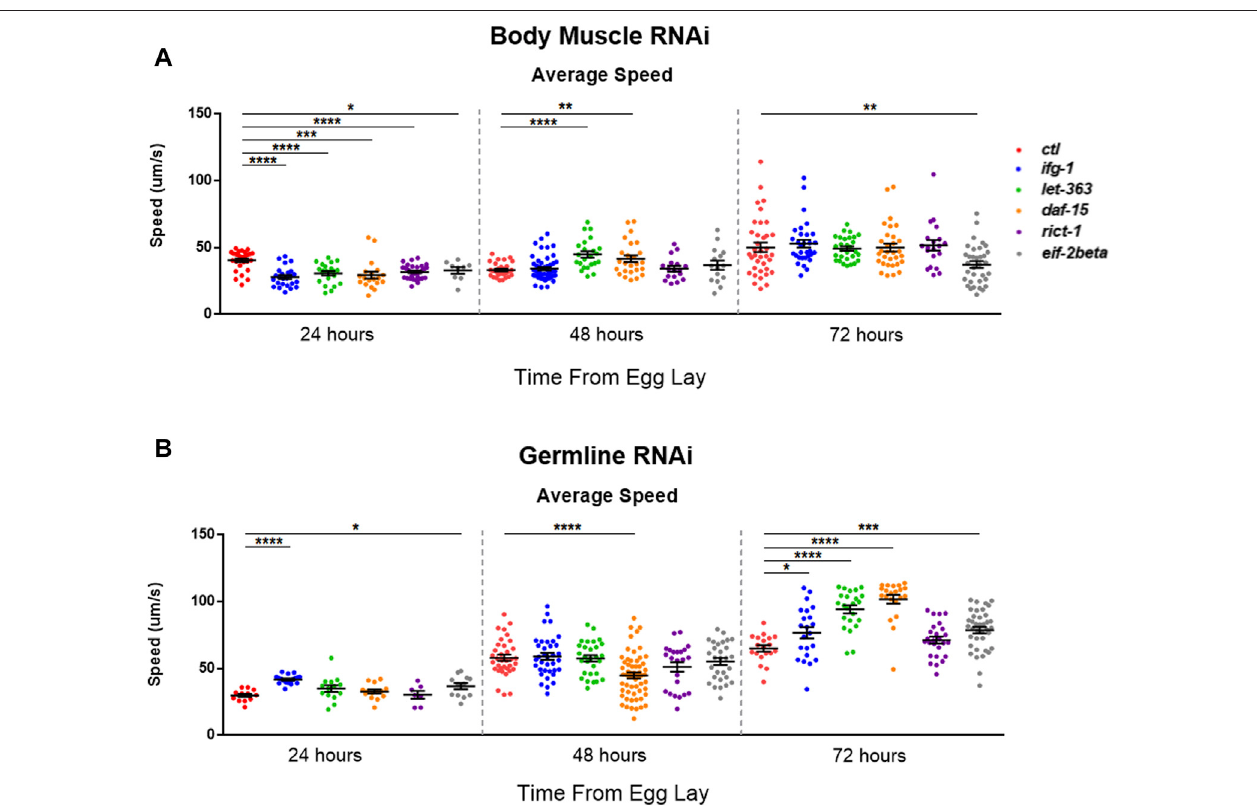
FIGURE 6 | Restricting mTOR in the germline increases motility while restriction in body muscle decreases motility.Average speed was measured on animals fed bacteria expressing dsRNA throughout development for the genes shown. (A) Motility in the WM118 body muscle-speci fi c RNAi strain at 24-, 48-, and 72-h. (B) Same as in (A) , but for motility in theMAH23germline-speci fi cRNAi strain. In each experiment, > 75worms weretracked for45s. Scatter plots display bars representing mean andstandarderrorofthemeanforallconditions.Statisticalcomparisonsweredoneusingtwo-tailedunpairedt-testswithWelch ’ sCorrection(* p < 0.05,** p < 0.01, *** p < 0.001, ***** p < 0.001). See Supplementary Table S9 for more